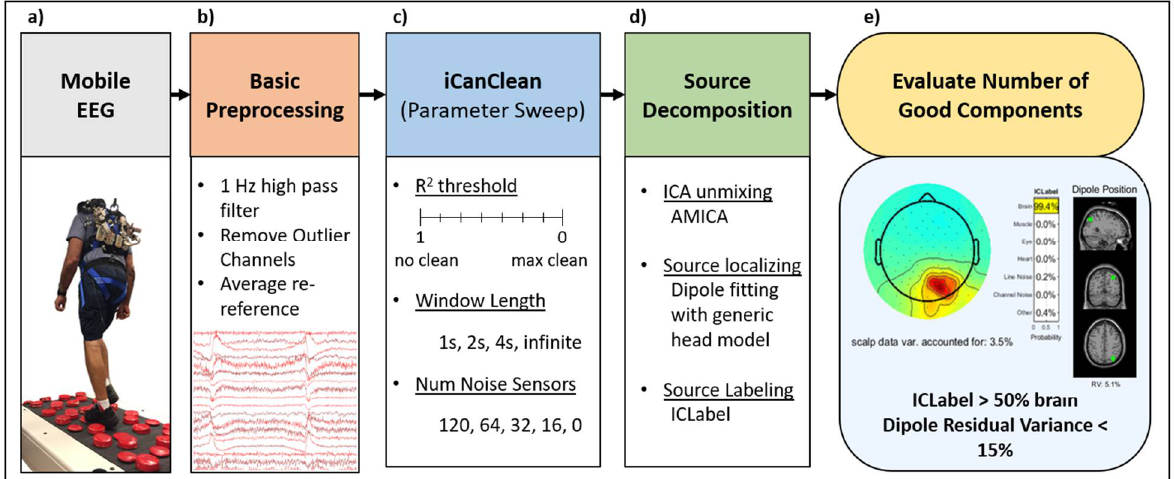
Figure 2. Processing pipeline from raw mobile EEG data to brain components. ( a ) Mobile EEG data were collected during flat and uneven terrain treadmill walking in younger, older, and low-functioning adults. ( b ) The data were high pass filtered and outlier channels were removed (channels with amplitudes greater than 3 × median). ( c ) iCanClean was used with different r 2 thresholds (cleaning aggressiveness), time windows, and numbers of noise channels. ( d ) Brain sources were separated using adaptive mixture independent component analysis and they were labeled with ICLabel. ( e ) Components with >50% likelihood of being a brain source (from ICLabel) and <15% residual variance (from eeglab dipfit) were marked as good components.